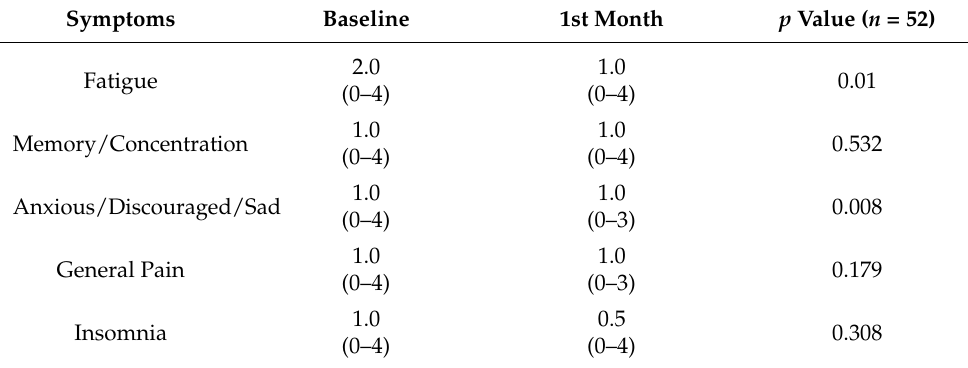
Table 3. Symptoms with a reported median level greater than or equal to 1: median (range) level of each symptom and comparison between baseline and M1 of follow-up. Symptoms Baseline 1st Month p Value ( n =